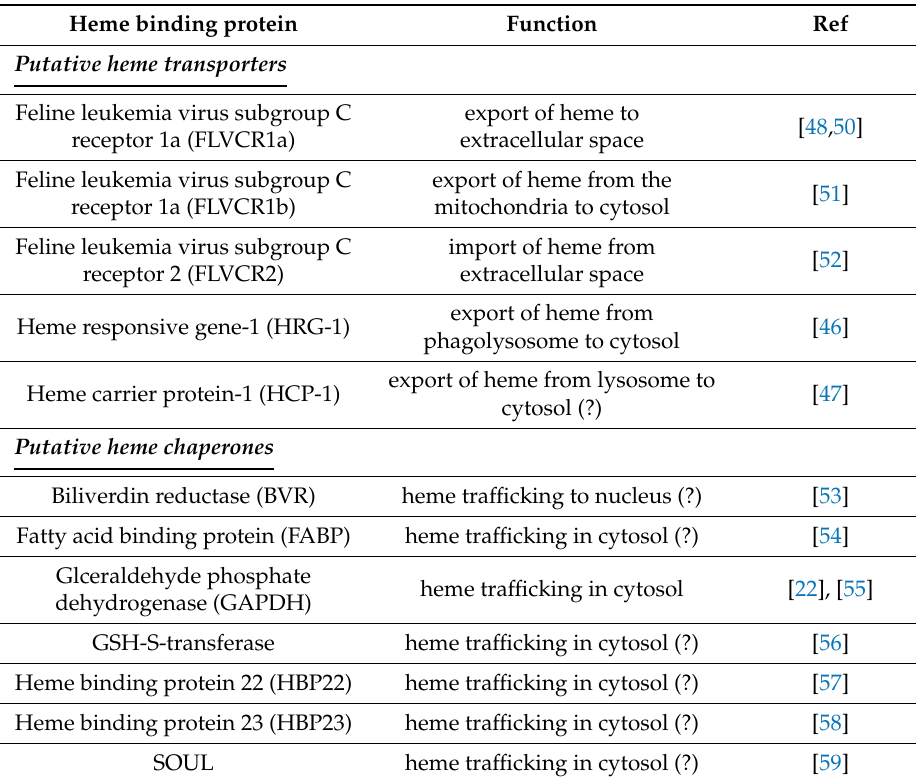
Table 2. Intracellular heme binding proteins in